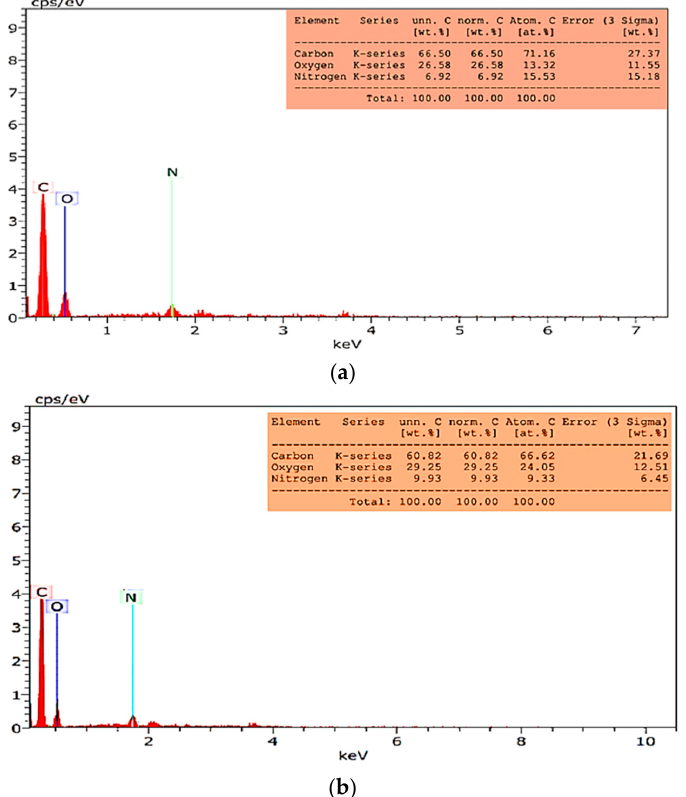
Polymers 2022 , 14 , x FOR PEER REVIEW Figure 3. EDS spectra of MOGN ( a ) and DOX–MOGN ( b ). Figure 3. EDS spectra of MOGN ( a ) and DOX–MOGN ( b ).